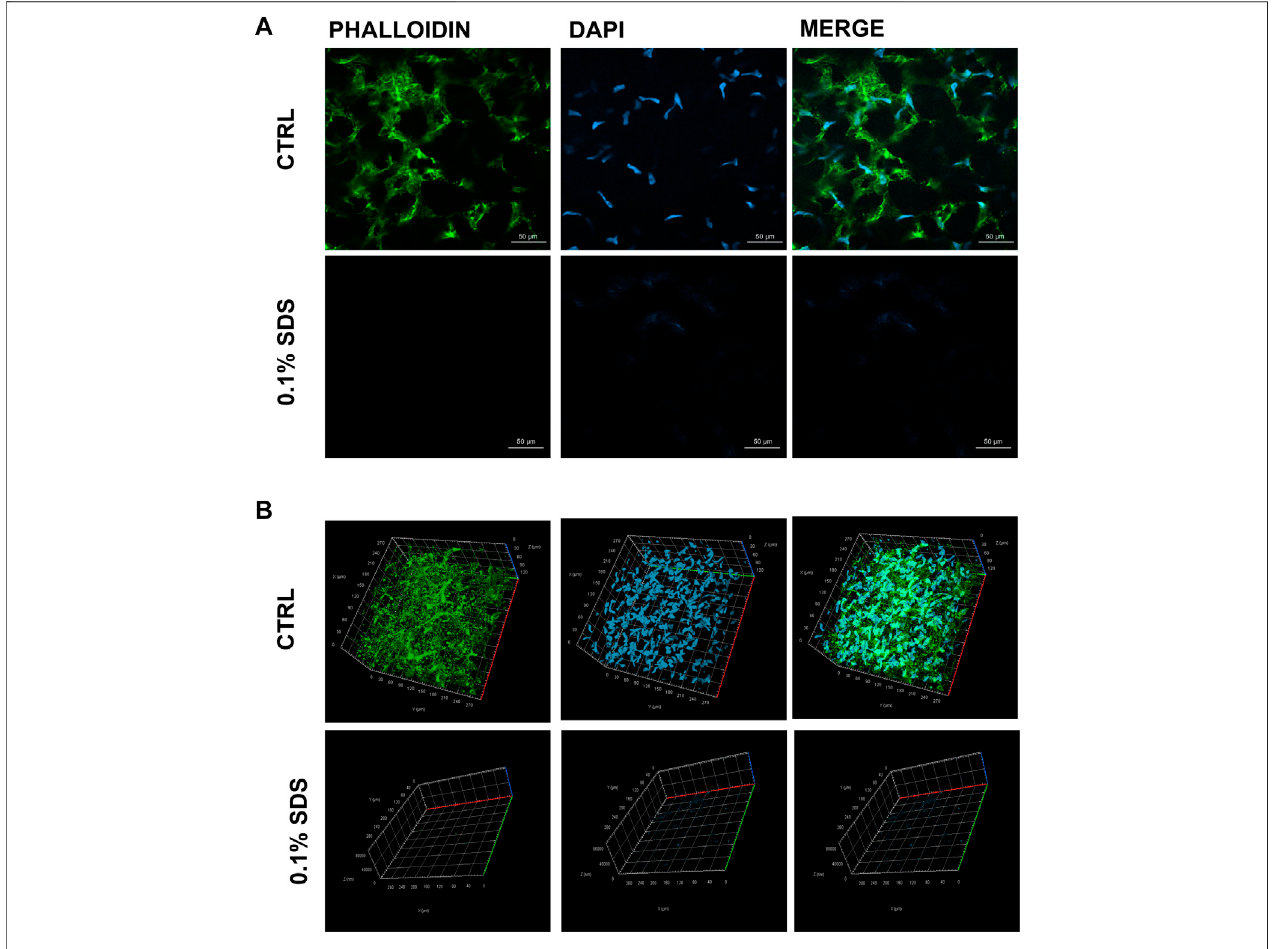
FIGURE 1 | Residual cellular material in decellularized lenticules. Representative (A) 2D and (B) 3D (Z-stack; x , y, and z axis) immuno fl uorescence images of lenticules treated or not with SDS (0.1%). Lenticules were directly immunostained ex vivo for F-actin (phalloind in green) and nuclei (DAPI in blue) ( n = 6).